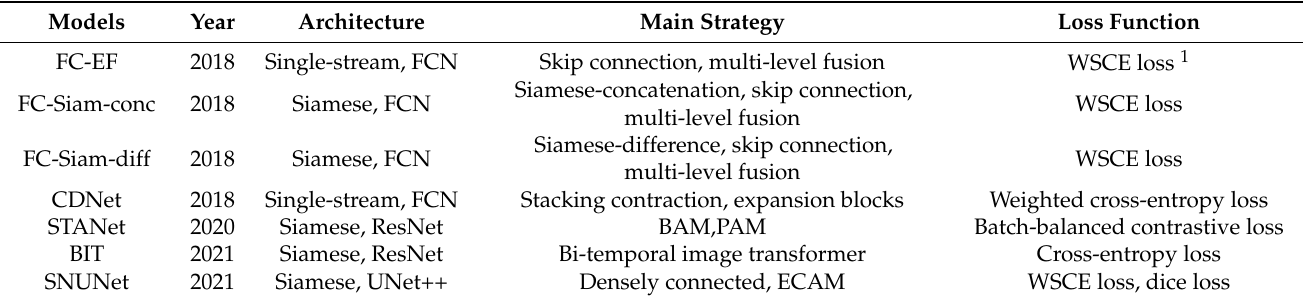
Table 3. Key characteristics of comparative methods.